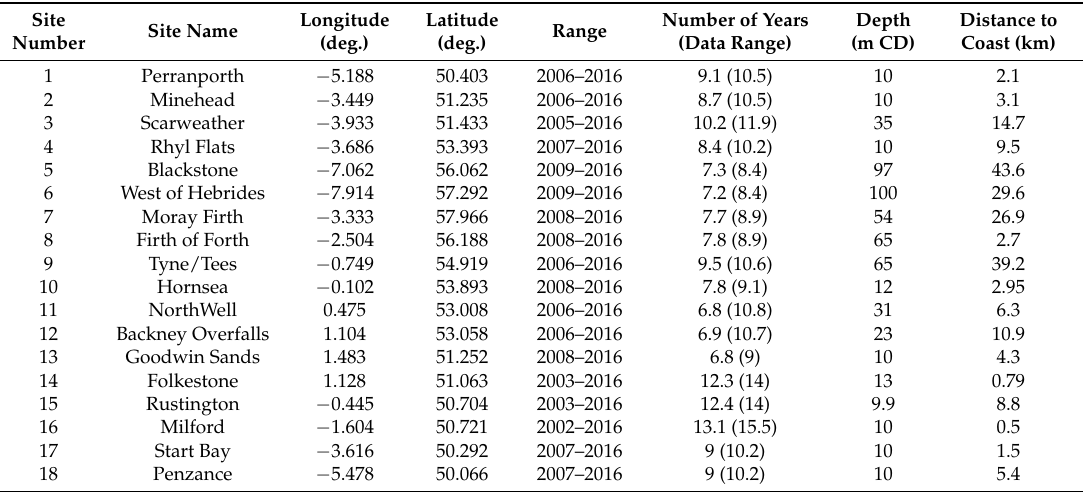
Figure 1. ( a ) Location of the selected buoys and their assigned number. ( b ) Location names and duration of the buoy records. Yellow: Centre for Environment, Fisheries and Aquaculture Science (CEFAS) WaveNet network; Blue: Channel Coastal Observatory (CCO) wave array. Table 1. Name, location, data length, depth, and distance from the coast for each study site.